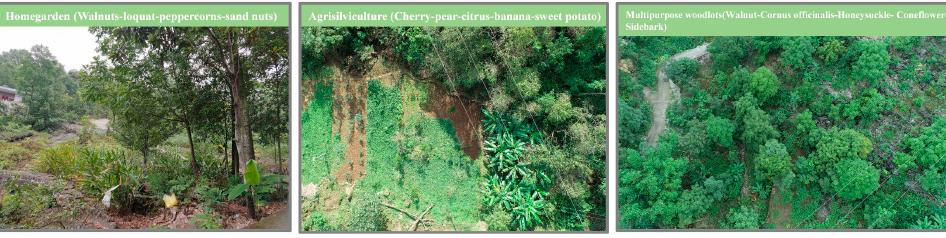
Figure 3. Schematic diagram of three types of AFS used in the control of KD in HJ. Finally, the example area of no–potential KD in the Karst Plateau trough valley of Shibing was selected as the third study area (hereafter this is referred to as SB) (108 ◦ 01 (cid:48) 36 (cid:48)(cid:48) – 108 ◦ 10 (cid:48) 52 (cid:48)(cid:48) E, 27 ◦ 13 (cid:48) 56 (cid:48)(cid:48) –27 ◦ 04 (cid:48) 51 (cid:48)(cid:48) N). The topography is high in the north and low in the south. Elevation ranges from 600 to 1250 m, with an average height of 912 m. It is